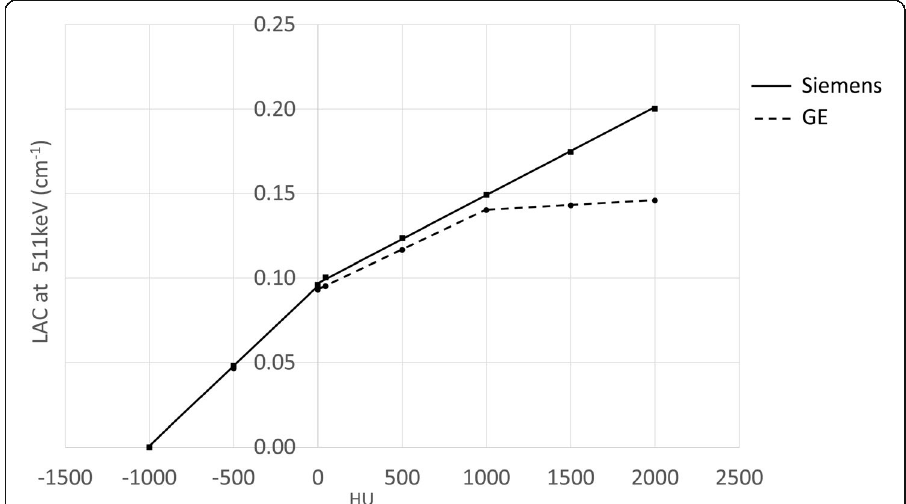
Fig. 1 Curves used by different vendors to scale Hounsfield unit in a 120 kVp CT image to LAC at 511